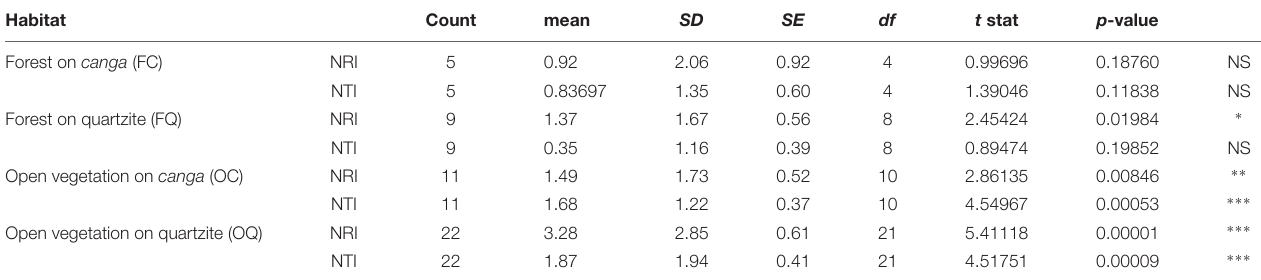
TABLE 2 | Results of one-tailed t -tests ascertaining whether mean NRI and NTI values of assemblages in different habitats (defined by substrate and vegetation physiognomy) differed significantly from zero. Habitat Count mean Forest on canga (FC) NRI Forest on quartzite